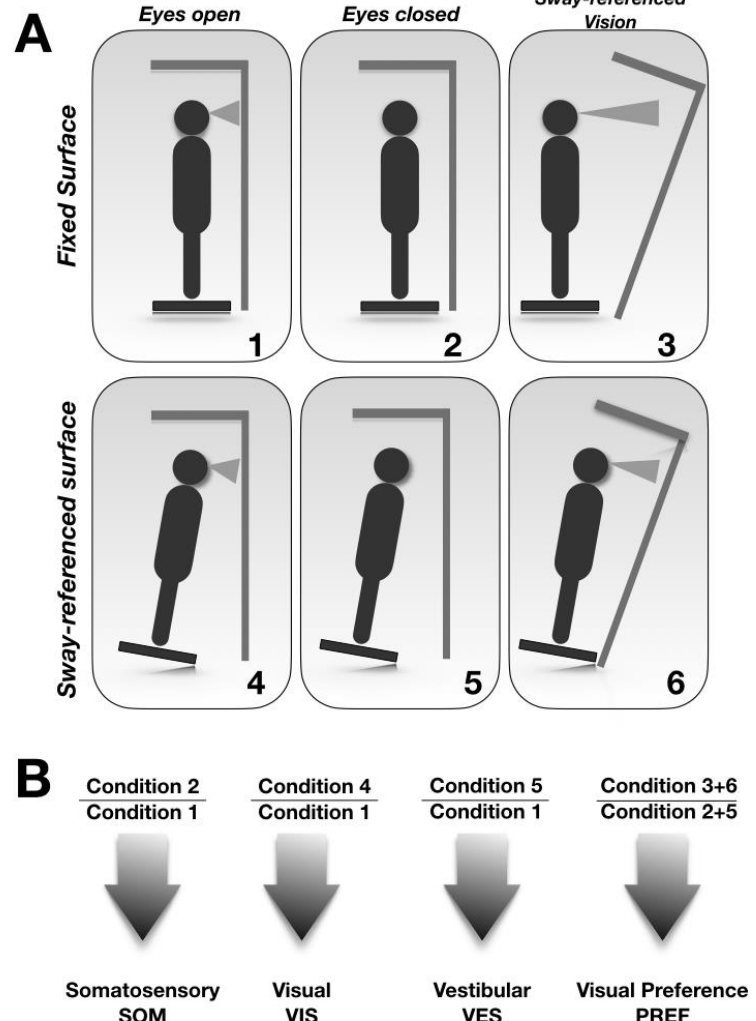
Figure 1. Computed Dynamic Posturography (see text for details). Six different test conditions, each lasting 20 s, were repeated three times to obtain more reliable values ( A ). The Sensory Analysis (SA) showed the contribution provided by the different sensorial afferences, and was obtained by the ratio of the different conditions ( B ).